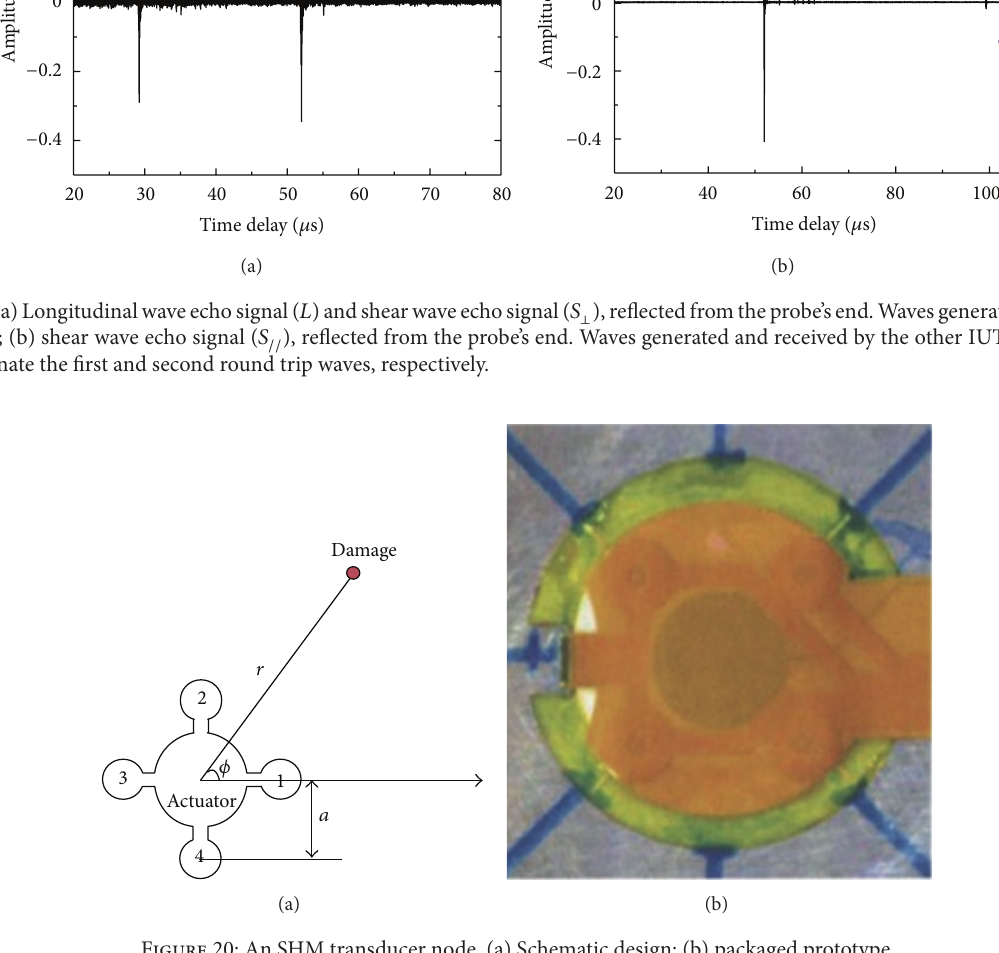
Figure 20: An SHM transducer node. (a) Schematic design; (b) packaged